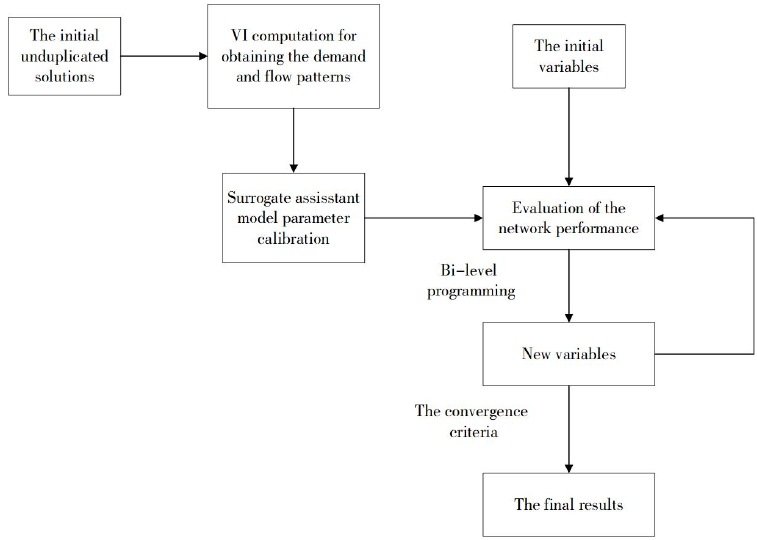
Figure 3. The algorithm flowchart.